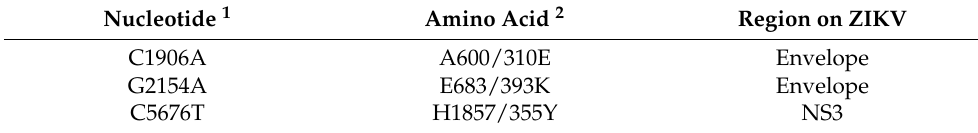
Table 1. Non-synonymous mutations of the ZIKV-PDK7-S3 and ZIKV-PDK7-S1.4 isolates.